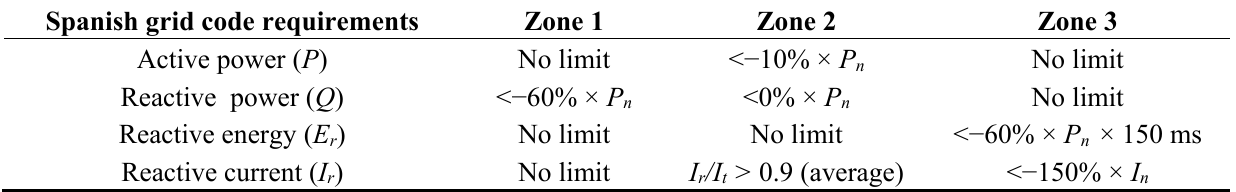
Table 1. Active and reactive requirements during three phase faults. WTG, wind turbine generator.